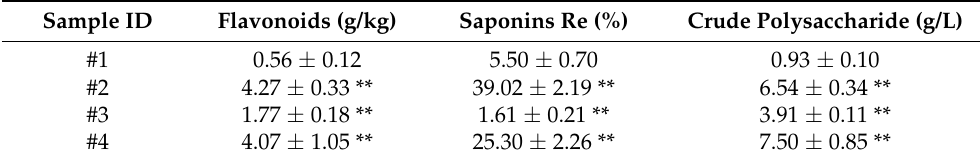
Table 3. Contents of functional components in herbal broth from the four different treatments.